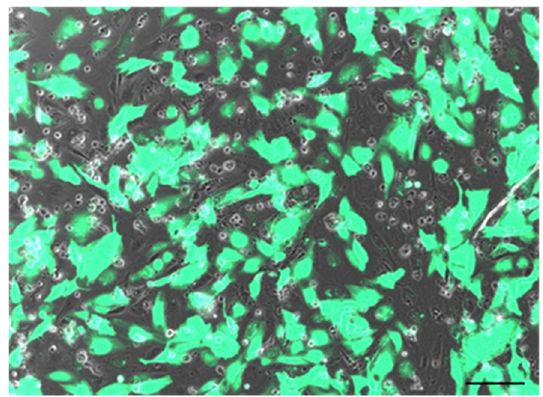
Figure 22. Results of pHCAECs’ transfection by nucleofection. Bar = 50 μ m.